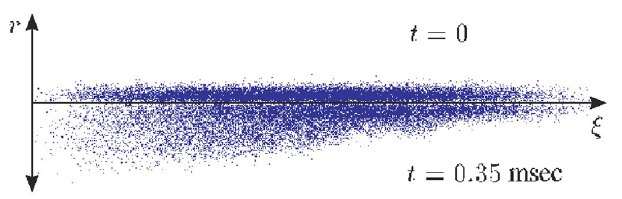
FIG. 76. (Color) Beam distribution in z (cid:2) (cid:12) plane for t (cid:3) 0 (top) and t (cid:3) 0 : 35 ms (bottom), without synchrotron motion [52]; (cid:12) (cid:3) s (cid:2) ct is the longitudinal distance from the bunch center.